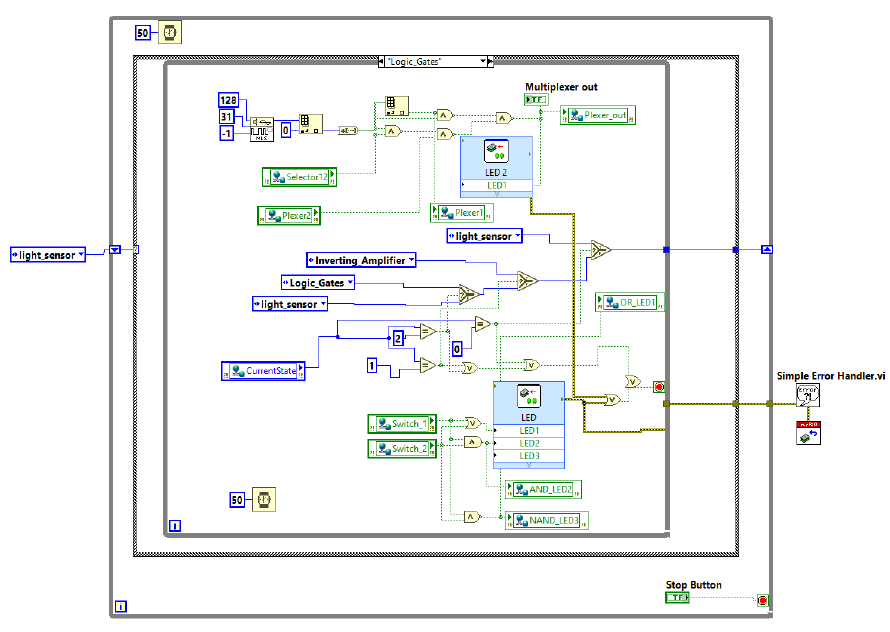
Figure 5. LabVIEW Code for Logic Gates state. The finite state machine LabVIEW code from different devices execute independently from one another (Figure 6).